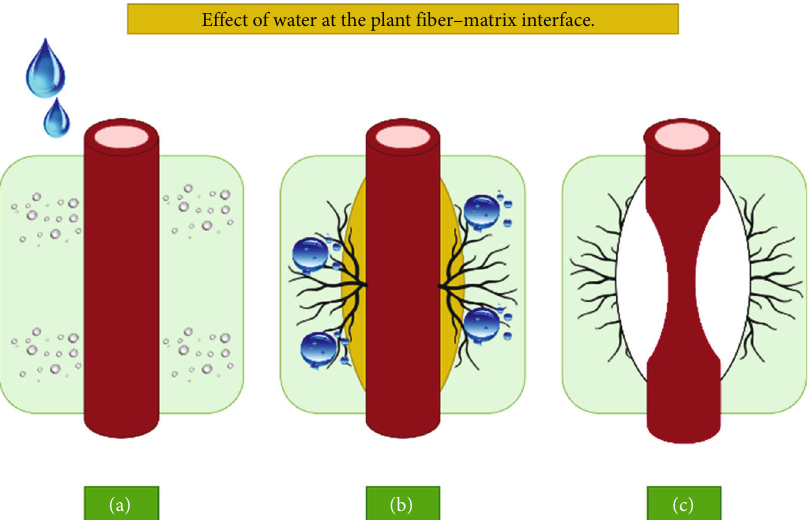
Figure 6: Mechanism of moisture absorption of natural fi ber. (a) Water di ff usion into the composite (b) Swelling of fi bers after moisture adsorption leading to microcracks within the matrix (c) Ultimate fi ber-matrix